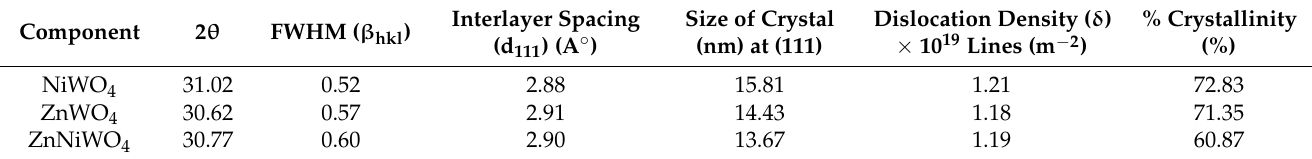
Figure 2. X-ray diffraction pattern of ZnWO 4 , NiWO 4 , and ZnNiWO 4 . Table 1. XRD parameters of the synthesized ZnWO 4 , NiWO 4 , and ZnNiWO 4 NPs.